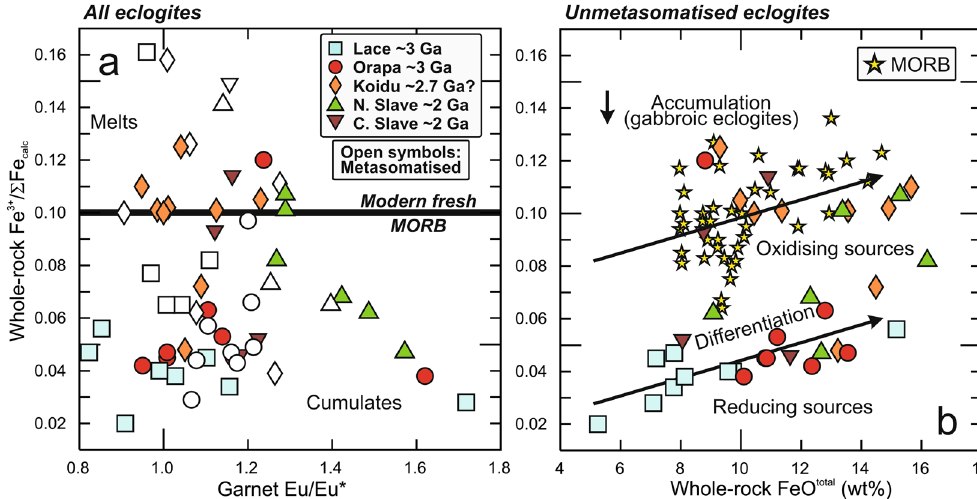
Figure 2. Effects of differentiation (oceanic crustal protolith). Fe 3 + / Σ Fe in reconstructed whole rocks as a function of ( a ) Eu/Eu * (chondrite-normalised Eu/(Sm * Gd)^0.5) in garnet, as a proxy for plagioclase accumulation and fractionation during protolith formation, and ( b ) FeO content in reconstructed whole rock mantle eclogite. In each eclogite suite, the lowest or one of the lowest Fe 3 + / Σ Fe is observed for samples with a strong cumulate signature (Eu/Eu *≫ 1). Average modern fresh MORB from 25 . The trend to increasing Fe 3 + / Σ Fe with increasing FeO in unmetasomatised eclogites from Lace and Orapa could be related to differentiation in the protoliths, whereas low Fe 3 + / Σ Fe in gabbroic eclogites may be due to accumulation; a similar trend is observed in modern fresh MORB (yellow stars) 25